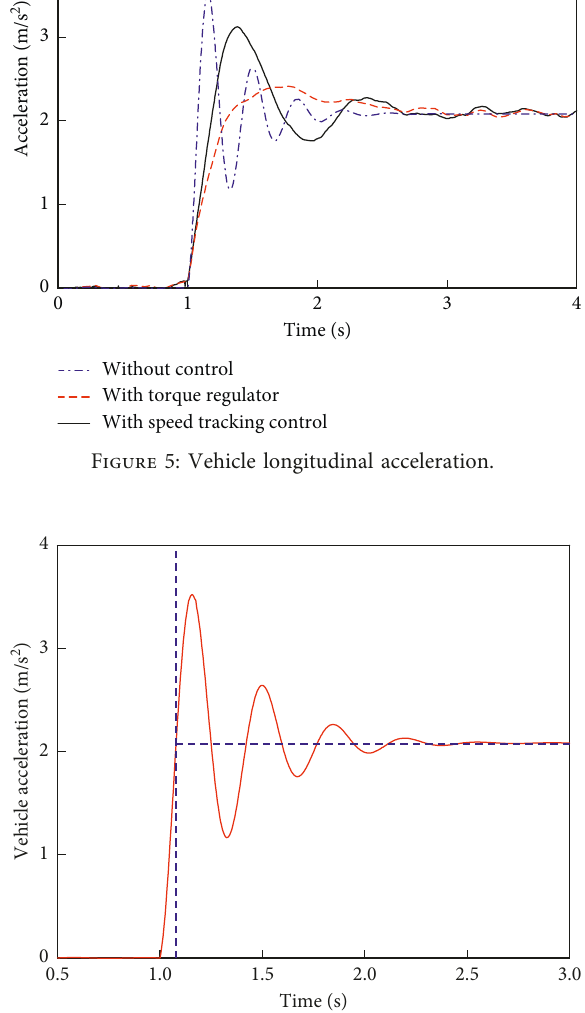
Figure 6: Acceleration without vibration